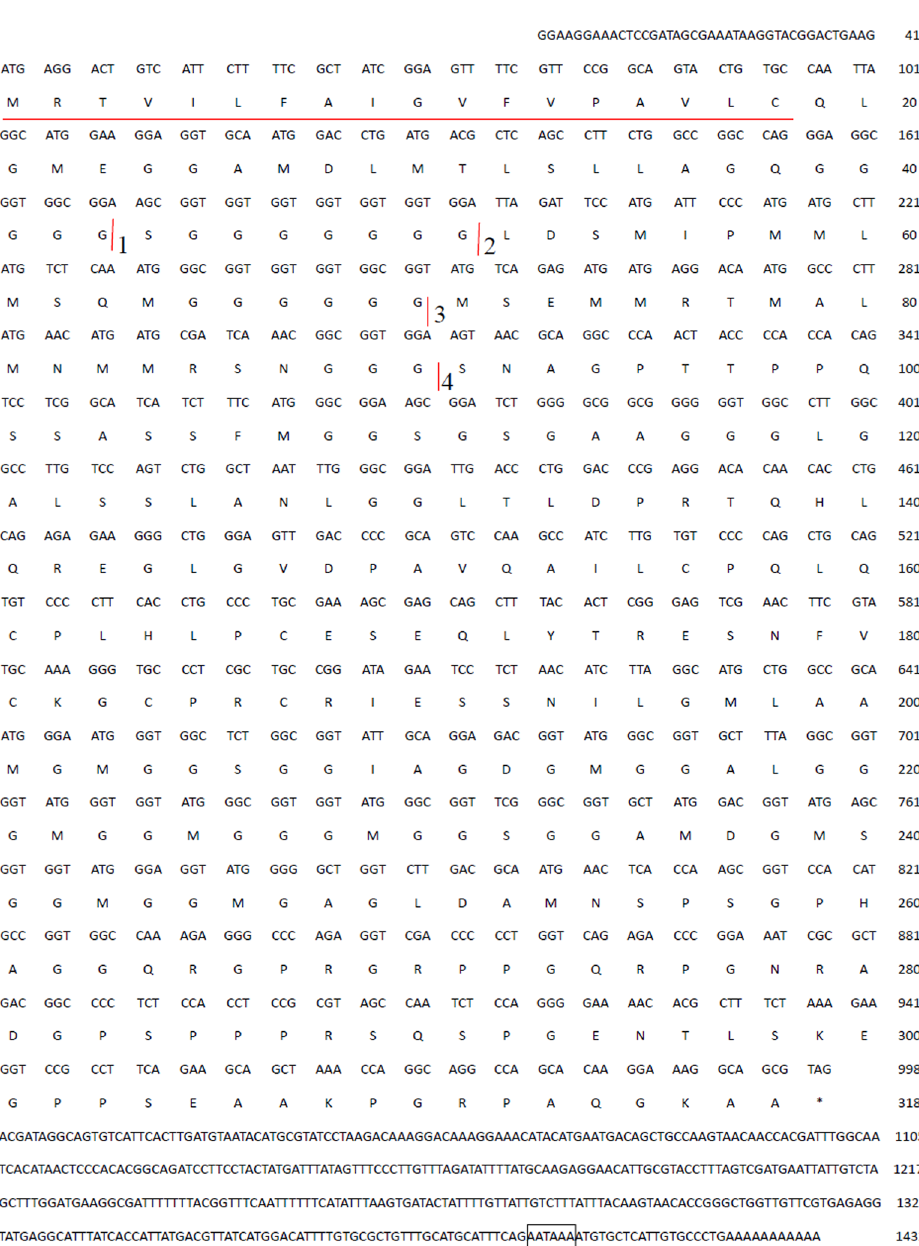
Fig 1. cDNA and deduced amino acid sequence of hic31. The putative signal peptide is shown underlined. The putative polyadenylation signal (AATATA) is shown underlined boxed. The cDNA sequence of hic31 has been submitted to Genebank (Accession No.